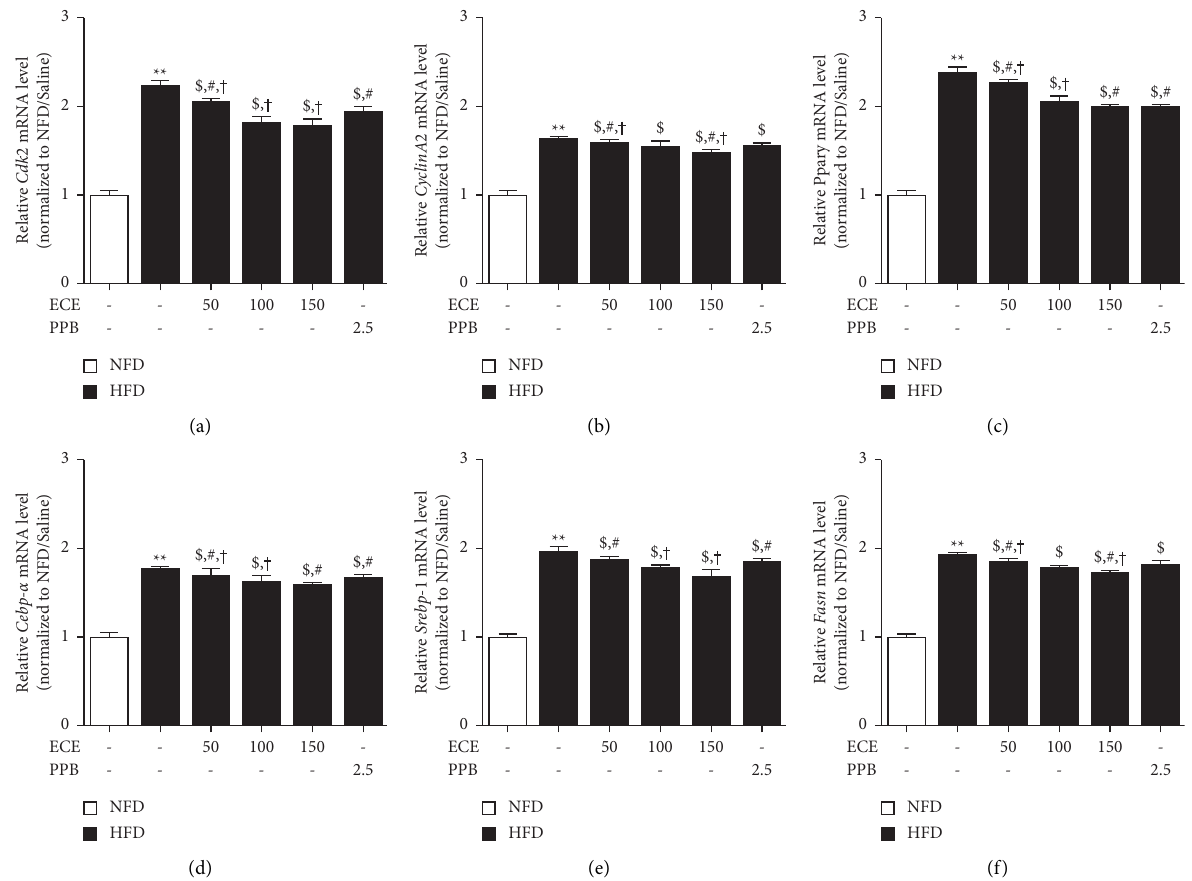
Figure 5: ECE and PPB reduce cell cycle reentry and adipogenesis in visceral adipose tissue of HFD mice with saline. The mRNA levels of (a) Cdk2, (b) cyclin A2, (c) ppar c , (d) cebp- α , (e) srebp-1, and (f) fasn in visceral adipose tissue of HFD mice measured by qRT-PCR. All results are shown as mean ± S.D. ∗∗ , p < 0 . 01, vs. NFD/saline; $ p < 0 . 05, vs. HFD/saline; # p < 0 . 05, vs. HFD/ECE100; † p < 0 . 01, vs. HFD/PPB (Mann–Whitney U test). Cdk2, cyclin-dependent kinase 2; cebp- α , CCAAT-enhancer binding protein alpha; ECE, Ecklonia cava extract; fasn, fatty acid synthase; HFD, high-fat diet; NFD, normal fat diet; ppar c , proliferator-activated receptor gamma; PPB, pyrogal-lol- phloroglucinol-6, 6-bieckol; Srebp-1, sterol regulatory element-binding